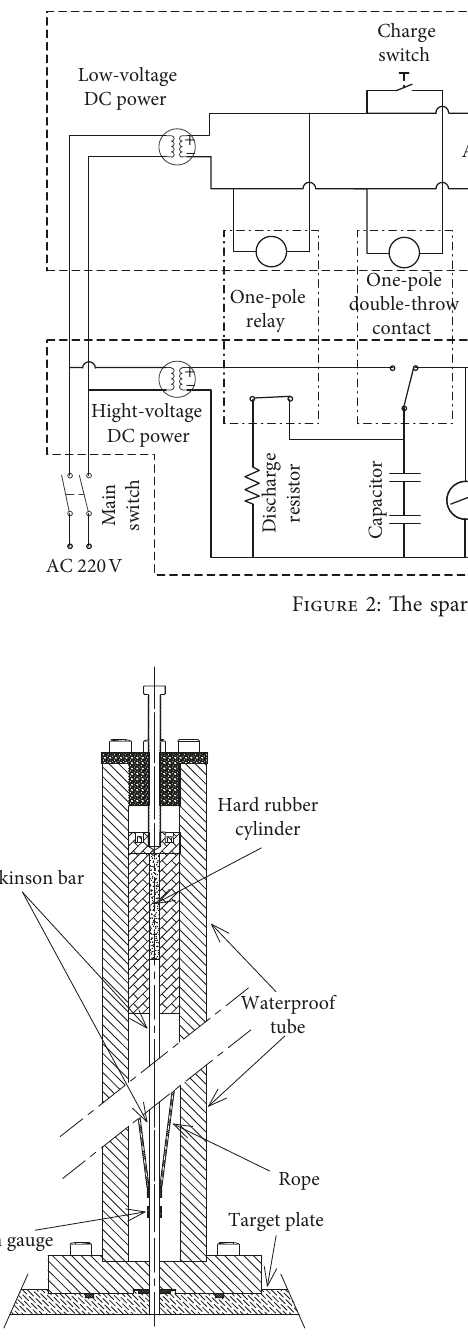
Figure 3: Detailed schematic of the apparatus.